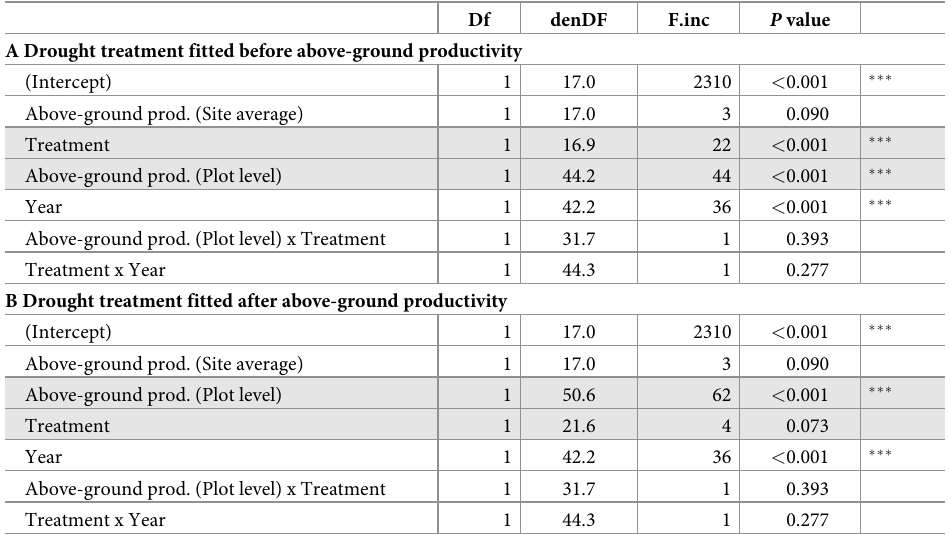
Table 2. Annual above-ground productivity as a